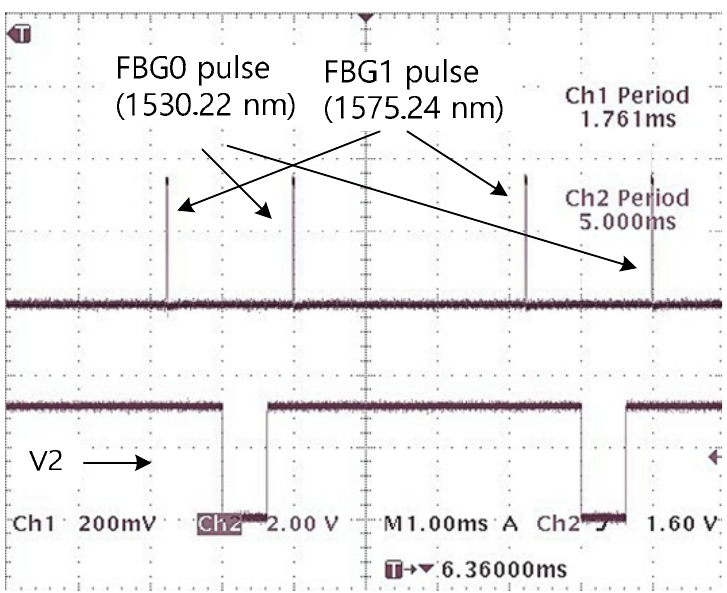
Figure 6. PD1 output pulse and V2 when the system was operating normally.